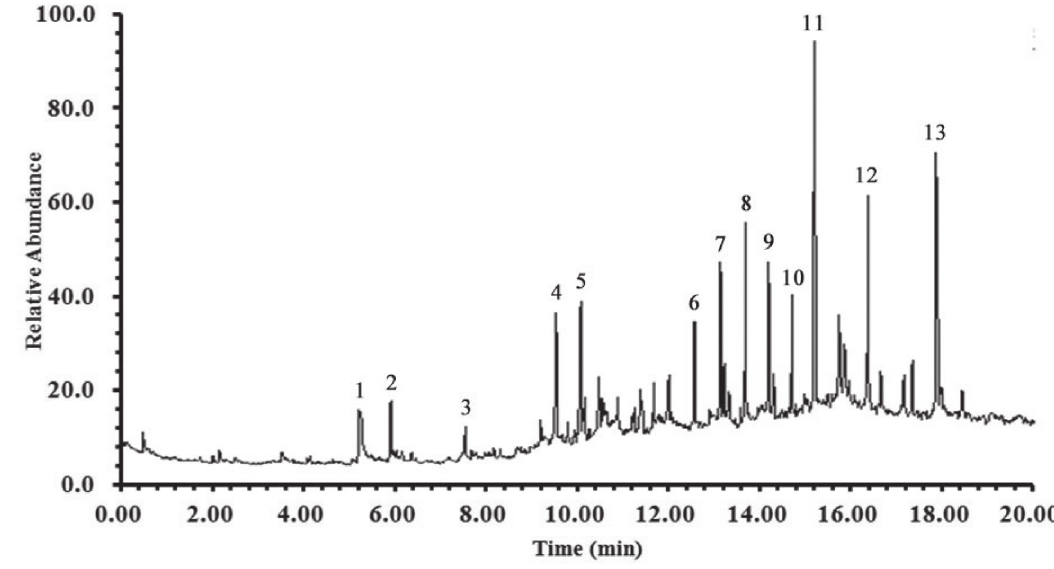
FIGURE 1 - The GC-MS analysis of EEEO is shown at different time with peak labeling corresponding to compounds